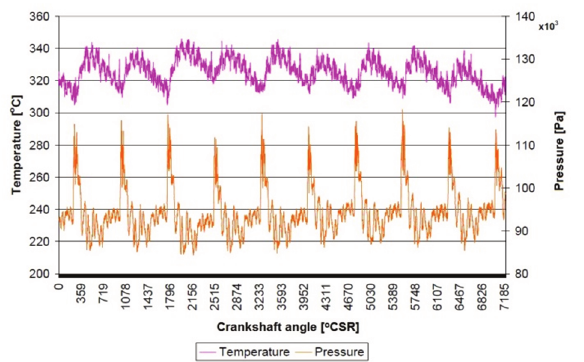
Fig. 6. Time courses of the quick-changeable temperature and exhaust gas pressure obtained from ten consecutive engine cycles for state 2 with the partially closed valve regulating the air supply to the engine cylinder (as in Figure 1)